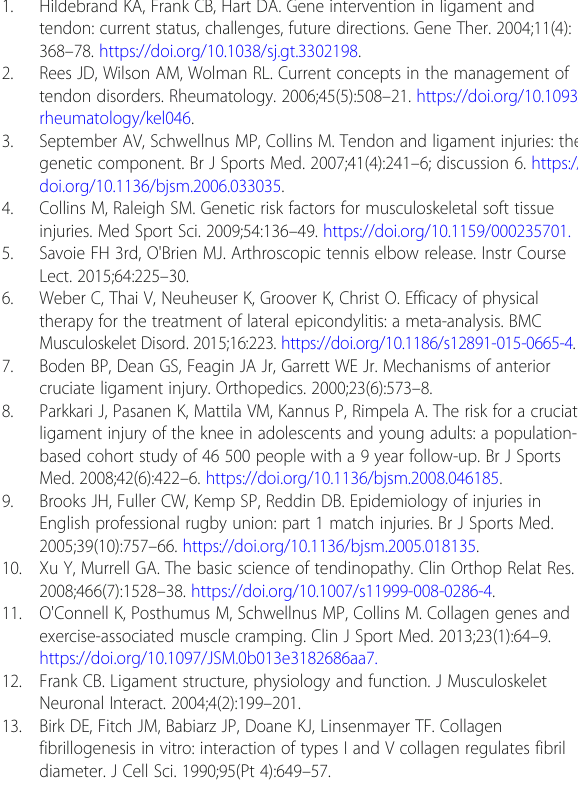
Additional file 2: Table S2. PRISMA checklist. (DOCX 30